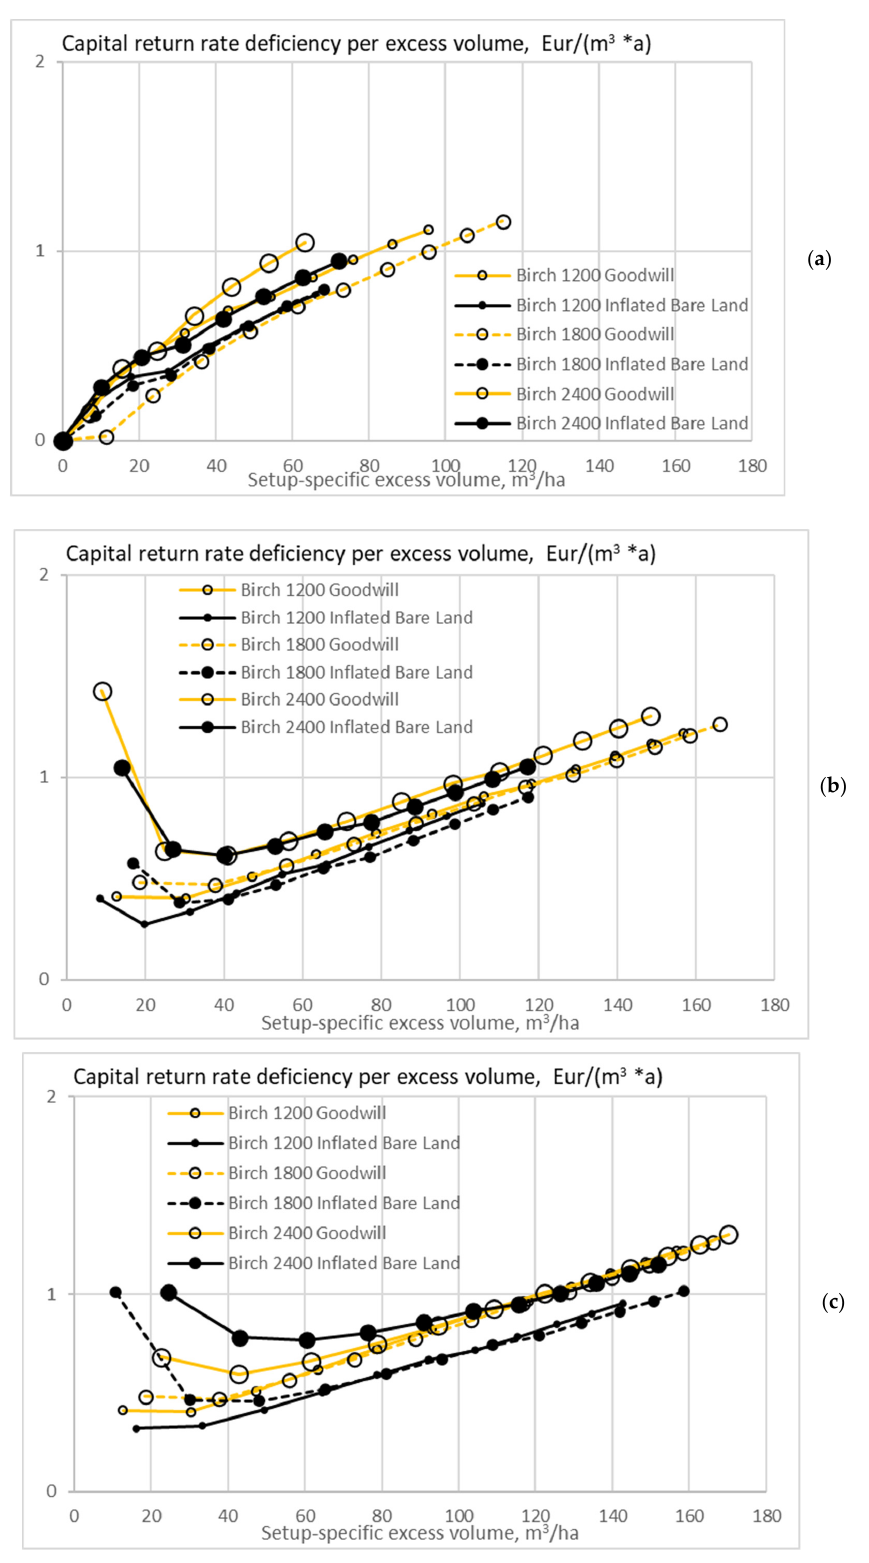
Figure 15. The expected value of capital return rate deficiency per excess volume unit on birch stands of different initial sapling densities, as a function of excess volume, when the growth model is applied as early as applicable, without any thinning restriction ( a ), in good-quality trees of at least 238 mm of diameter only removed in thinning ( b ), and without any commercial thinning ( c ). Inflated capitalization is introduced either as proportional goodwill or as inflated bare land value.